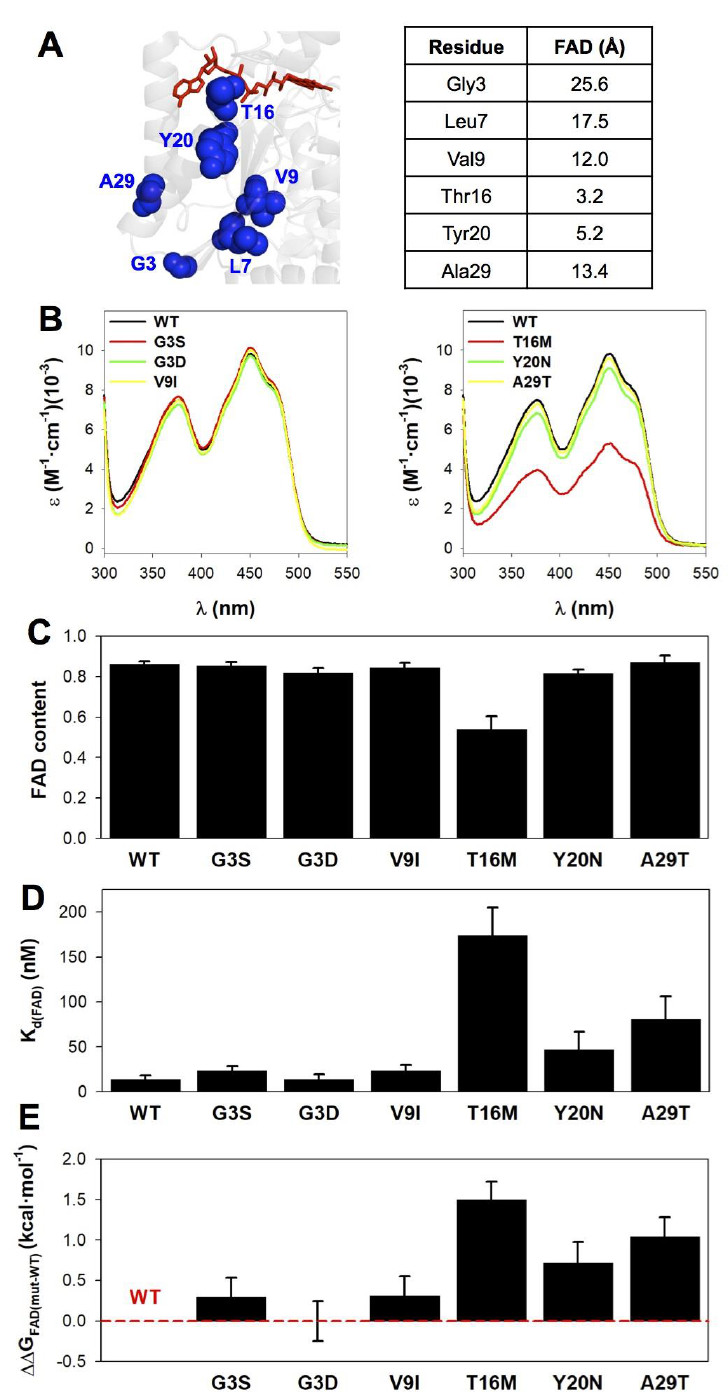
Figure 5. FAD content and binding affinity in purified NQO1 variants. ( A ) Location of mutated residues and minimal distances to the FAD molecule (using the structure with PDB code 2F1O). ( B ) Near-UV/visible absorption spectra of NQO1 variants. ( C ) FAD content (per NQO1 monomer) derived from absorption spectra (considering a ε 450 = 11,300 M −1 ·cm −1 ). ( D ) FAD-binding affinity of NQO1 apo proteins determined by fluorescence titrations. ( E ) Difference in binding free energies (ΔΔG FAD ) between a given mutant and the WT protein. Errors in ΔΔG FAD are those determined from linear propagation. Data in B–C are mean ± s.d. from at least three different purifications, and in D–E, from two different titrations with two different preparations of apo-proteins.